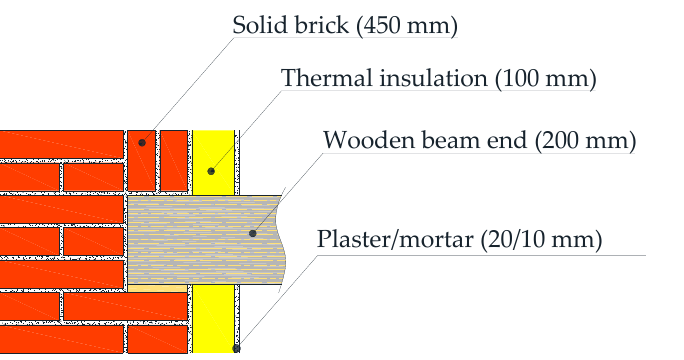
Figure 2. Scheme of the masonry with the wooden beam end—a vertical cross-section.